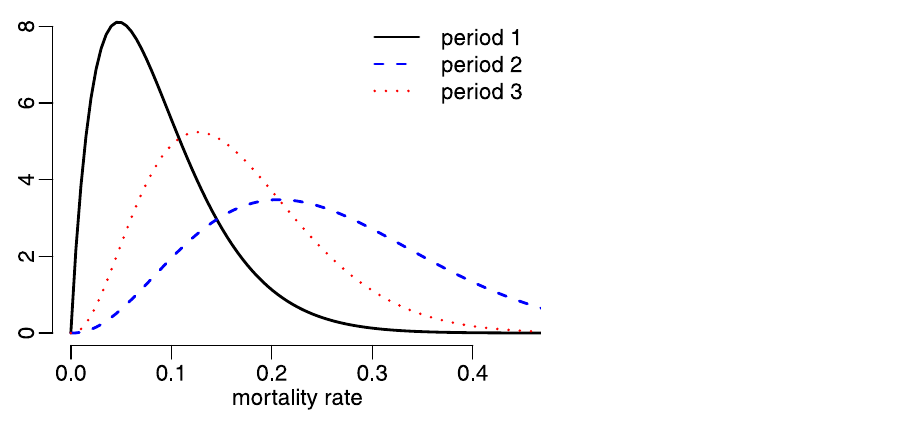
Fig 10. Fitted beta densities, county